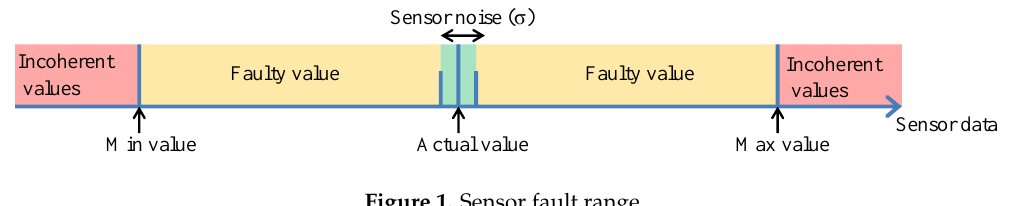
Figure 1. Sensor fault